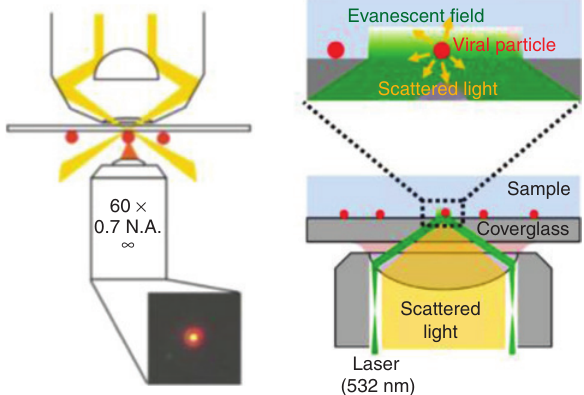
Figure 1: A schematic of two dark-field microscopy configurations. Left: A dark-field condenser illuminates the substrate at angles higher than the collection numerical aperture. Only scattered light is collected, resulting in images with a dark background. Right: Excitation light from a dark-field immersion epi-objective is totally internally reflected at the coverglass-sample interface. While a dark- field condenser allows detection of nanoparticles anywhere within a thick transparent sample, TIRM tends to have better stray light rejection but is limited to detecting particles within about 200 nm of the coverglass-sample interface. (Left: Adapted from [44]. Right: Adapted from [31]).